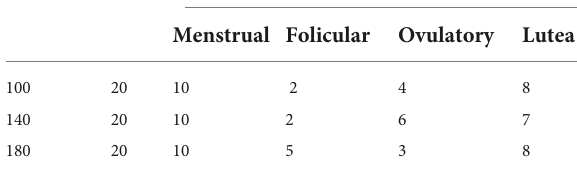
Menstrual Folicular Ovulatory Lutea